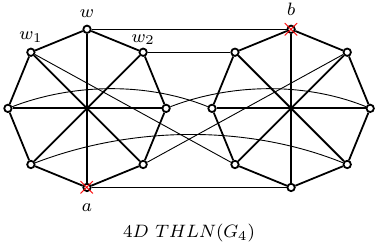
Figure 2. Example of weak